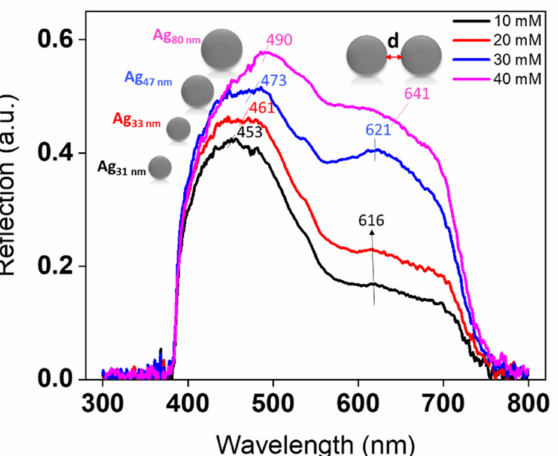
Figure 7. Spectral evolution of reflection of AgNPs/PMMA nanocomposites upon varying the concentration of Ag